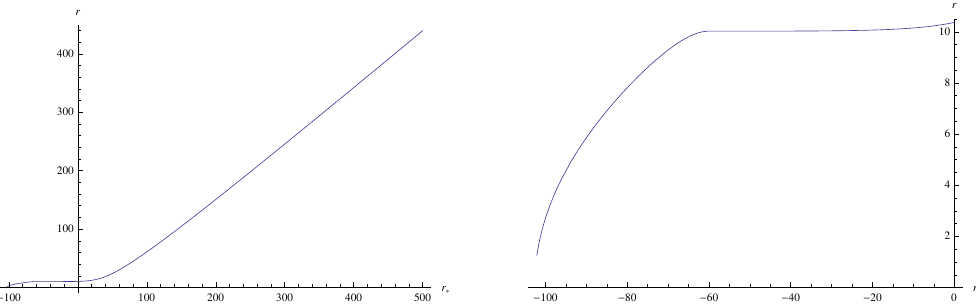
Figure 8 . The radius r for (cid:20)m 0 = 50, r (cid:3) s = (cid:0) 60 < a (cid:3) , a 0 = 10 and (cid:11) = 0 : 05. The plot on the left shows that the radius r increases as r (cid:3) decreases just inside the neck, but starts to decrease from r (cid:3) ’ (cid:0) 60 : 003. The plot on the right shows a magni(cid:12)ed view of the same diagram of r vs. r (cid:3) starting from the inner boundary of the incompressible (cid:13)uid at r (cid:3) = r inner r ’ 1 : 25), where P vanishes, up to the point r (cid:3) =